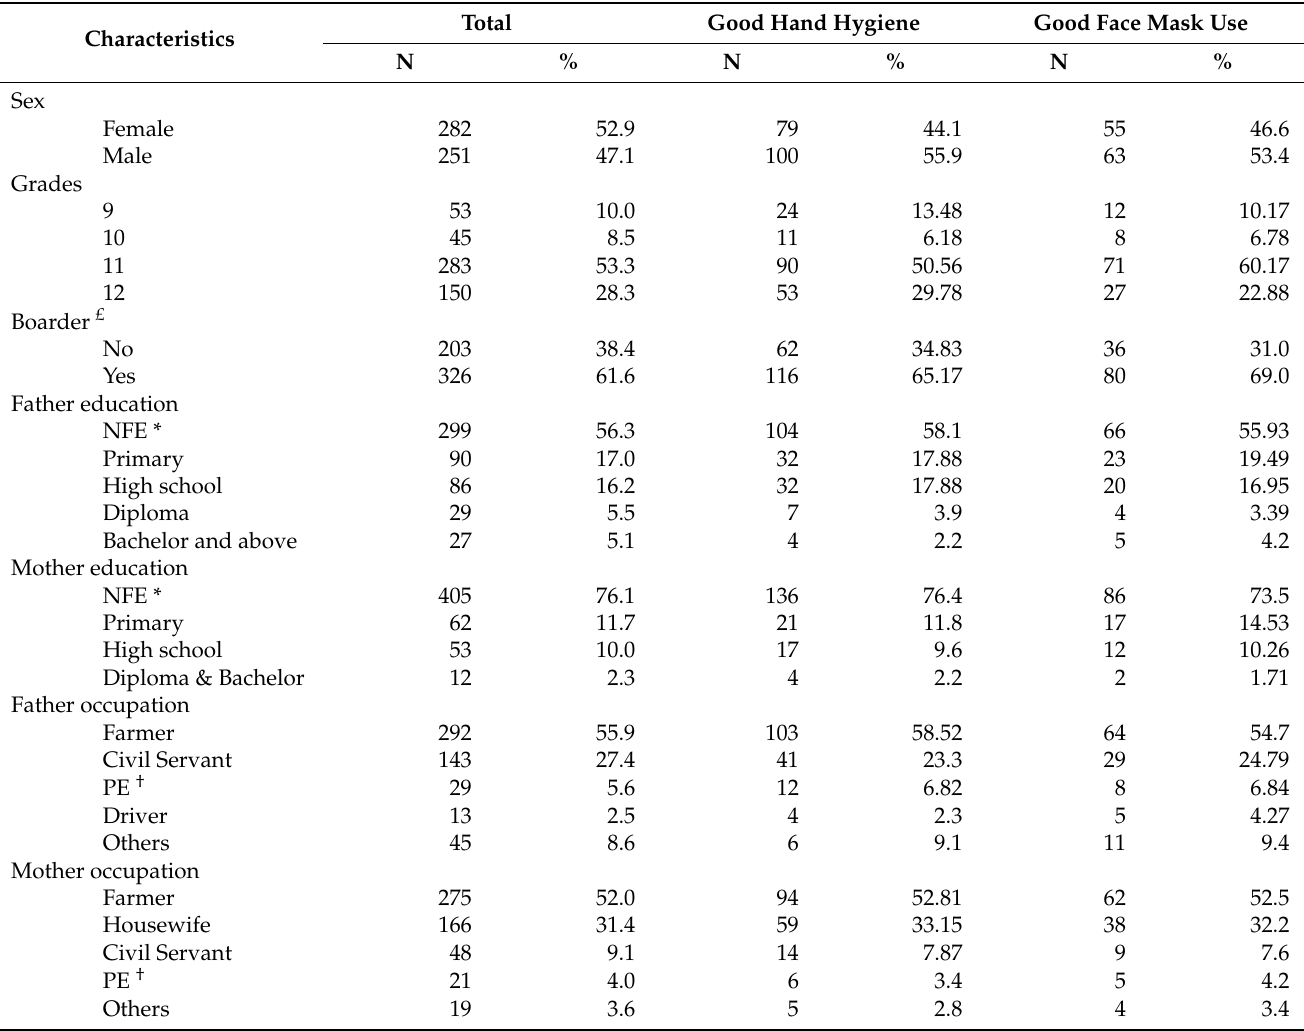
Table 1. Sociodemographic characteristics of the study population, Mongar Higher Secondary School,